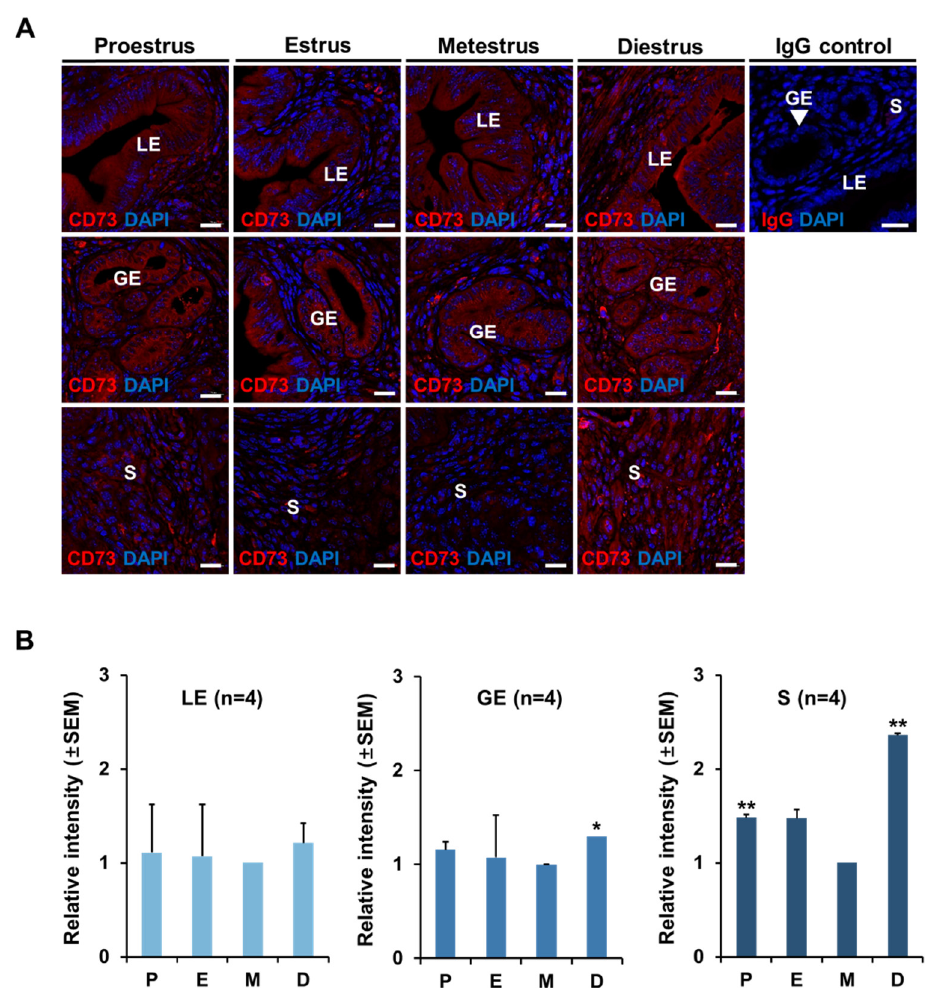
Figure 2. CD73 localization in mouse uterus at each stage of estrous cycle. ( A ) Immunofluorescence analysis of CD73 at four stages of estrous cycle (each group n = 4). Blue color represents DAPI in the uterus. Normal rabbit IgG (IgG control) was used as a negative control. LE, luminal epithelium; GE, glandular epithelium; S, stroma. The white scale bars indicate 20 μm. ( B ) Quantitation of the relative levels of CD73 in mouse uterus during estrous cycle using imaging software Carl Zeiss ZEN 2012 in luminal epithelium (LE), glandular epithelium (GE), and stroma (S), respectively. Each value is expressed as a relative value based on metestrus stage of estrous cycle. Four animals in each group were examined. P, proestrus; E, estrus; M, metestrus; D, diestrus. The one-way ANOVA analysis was used to calculate p -value, * p -value < 0.01, ** p -value < 0.05.